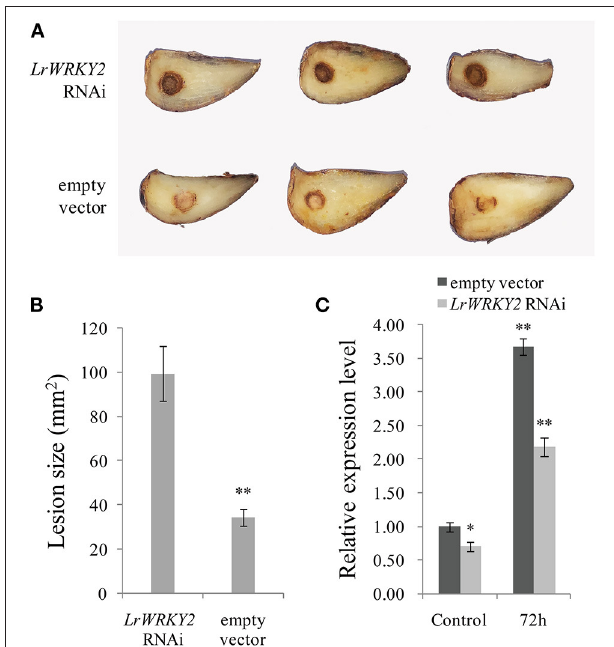
FIGURE 4 | Analysis of the hairpin RNA targeting LrWRKY2 transiently expressed in L. regale scales. (A) The symptoms of L. regale scales after F. oxysporum inoculation, in which the LrWRKY2 RNAi vector and the empty RNAi vector were expressed, respectively. (B) The lesion areas in LrWRKY2 -RNAi fragment expressed scales were significantly bigger than that in the empty RNAi vector expressed scales (** p < 0.01). (C) The expression levels of LrWRKY2 in LrWRKY2 -RNAi fragment expressed scales and the empty RNAi vector expressed scales were evaluated by qRT-PCR. Bars represent the standard errors of three biological replicates. The results was calculated by the 2 − 11 Ct method and analyzed by the t test (* p < 0.05, ** p <